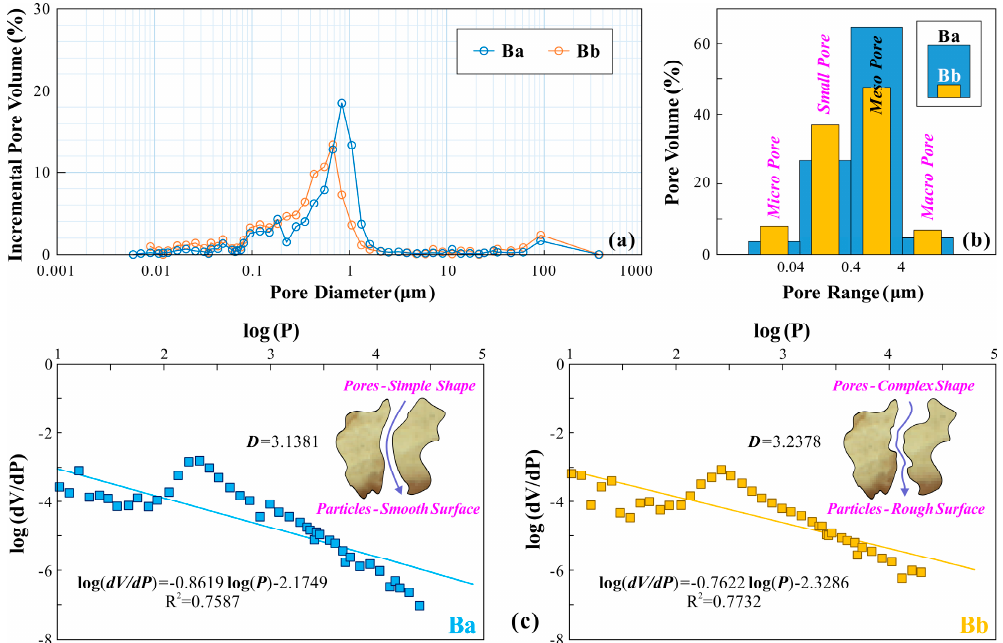
Figure 8. The micro-scale pore characteristics of the clay around the Ba (CLBA) and clay around Bb (CLBB). ( a ) Pore distribution, ( b ) pore type, and ( c ) morphological fractal dimension.